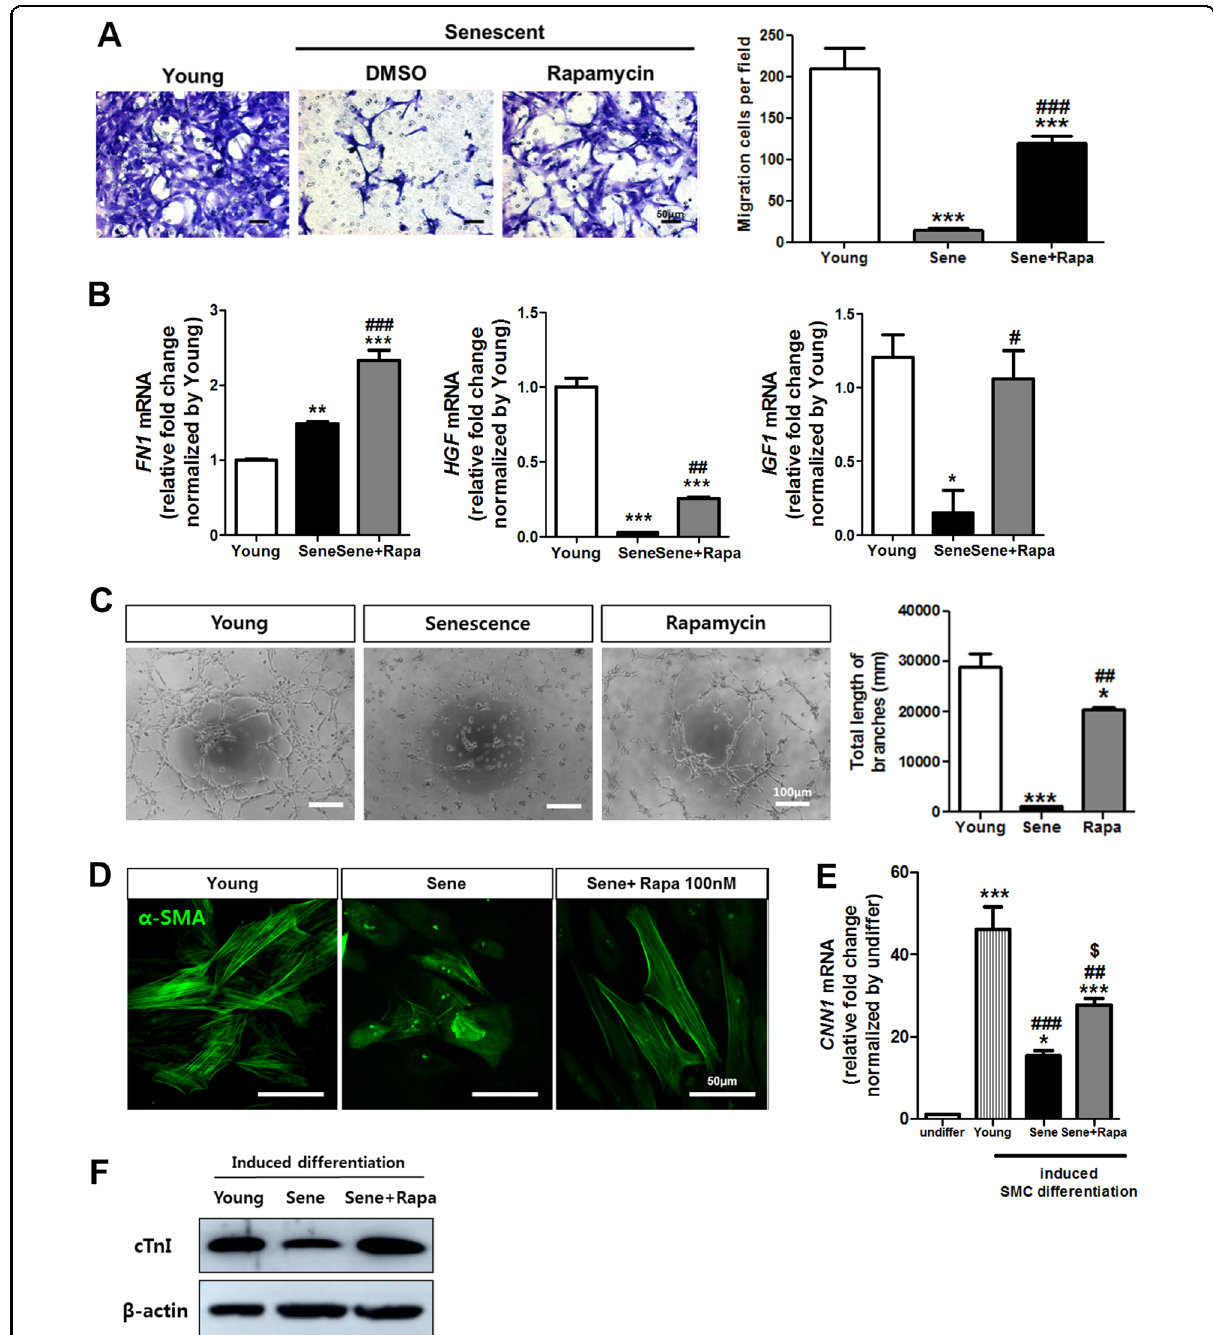
Fig. 4 The effect of rapamycin on the migration and tube formation ability of senescent CPCs. a The migration ability of the senescent hCPCs was evaluated after prolonged rapamycin treatment via transwell migration assays. b The expression of cell migration-related markers such as FN1, HGF, and IGF1 was assessed in senescent hCPCs after prolonged rapamycin treatment by qRT-PCR (** p ≤ 0.01, vs. young, ## p ≤ 0.01, vs. senescent, n = 3). c Tube formation ability was assessed in the young and senescent hCPCs after prolonged rapamycin treatment by Matrigel tube formation assay (*** p ≤ 0.001 vs. young, # p , vs. senescent, n = 3). d Immuno fl uorescence was performed with antibodies against smooth muscle α -actin ( α -SMA). e Analysis of smooth muscle cell marker CNN1 in young and senescent hCPCs after prolonged rapamycin treatment by qRT-PCR (** p ≤ 0.01, vs. undifferentiated, *** p ≤ 0.001, vs. undifferentiated, # p , vs. young, $p , vs. senescent, n = 3). f Expression of cTnI after induced myogenic differentiation was investigated by western blotting. Error bars indicate